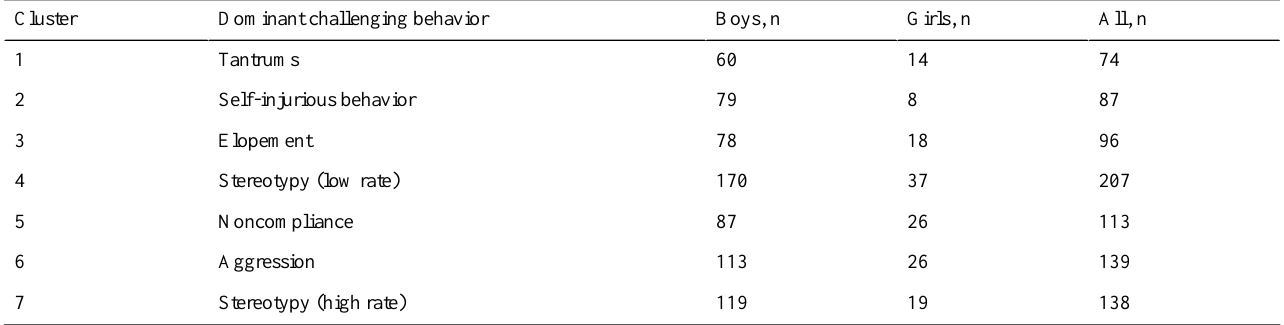
Table 1. Breakdown of identified